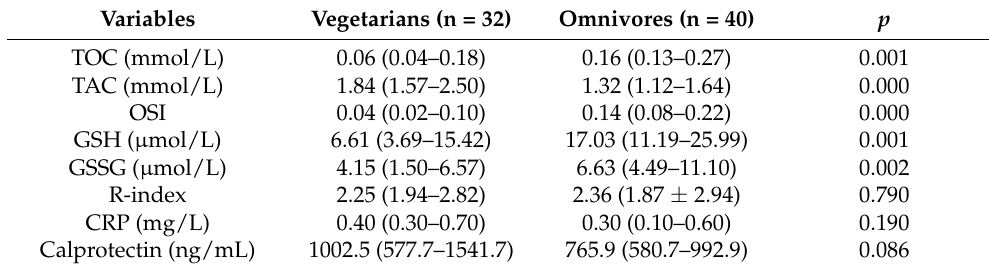
Table 3. Differences in biochemical parameters between children on vegetarian and omnivorous diets.